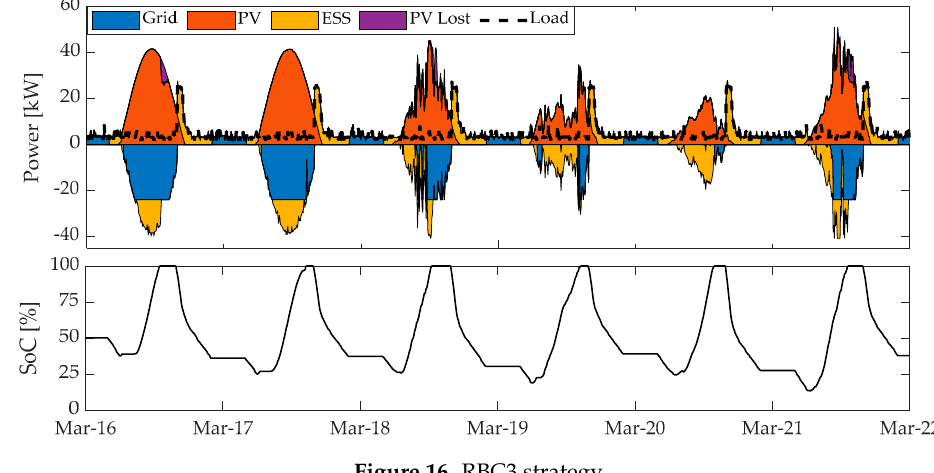
Figure 16. RBC3 Figure 16. RBC3 strategy. Figure 16. RBC3 strategy.